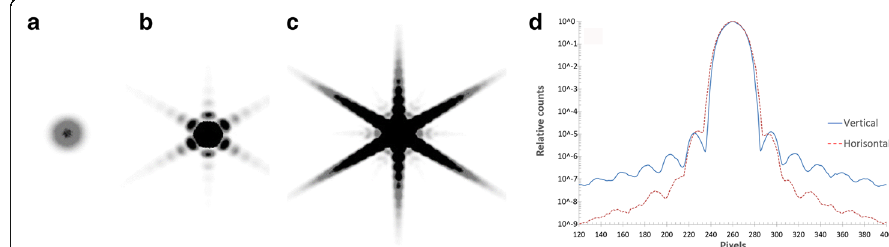
Fig. 1 MC simulation of a gamma camera image of a 177 Lu point source revealing a low-intensity star pattern. Window settings from non-saturated values ( a ) to pronounced saturation of the high signal values ( b , c ). The relative counts versus pixels for vertical and horizontal line profiles through the center of the point source ( d